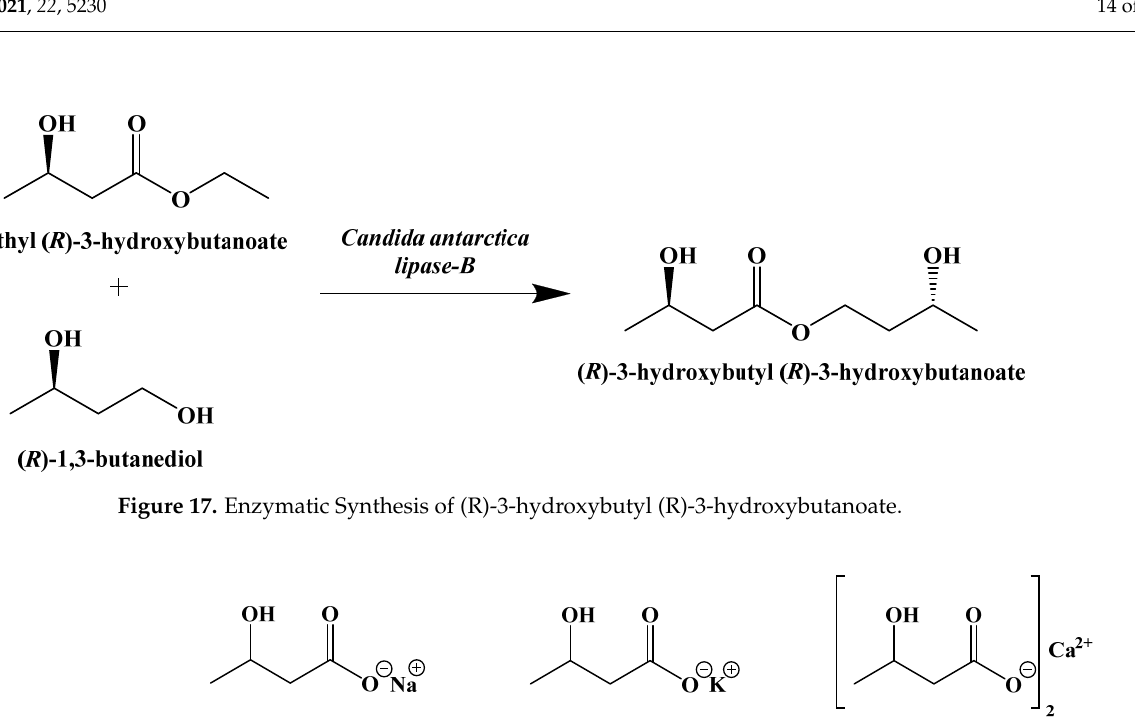
administration [97,98].